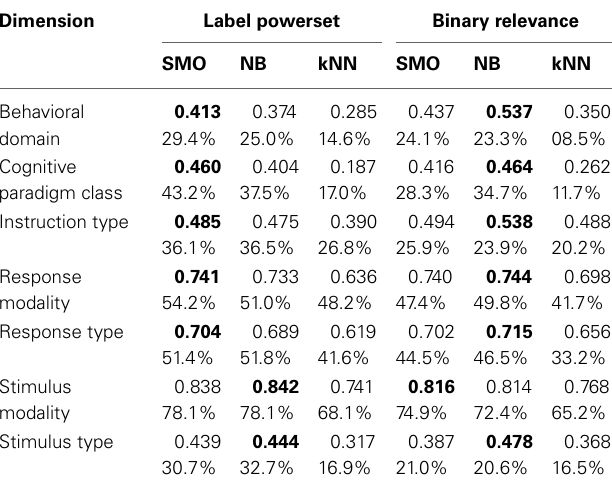
Table 2 | Performance of SMO, NB, and kNN under the two problem transformation methods, label powerset (LP) and binary relevance